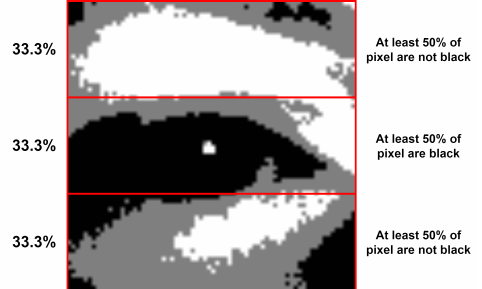
Figure 5. Black rule requirements for first patch’s selection